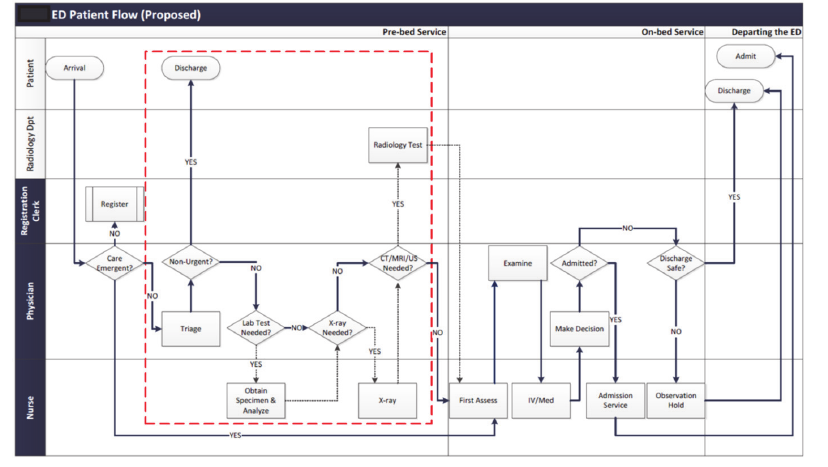
Fig. 6 . A proposed patient flow for the